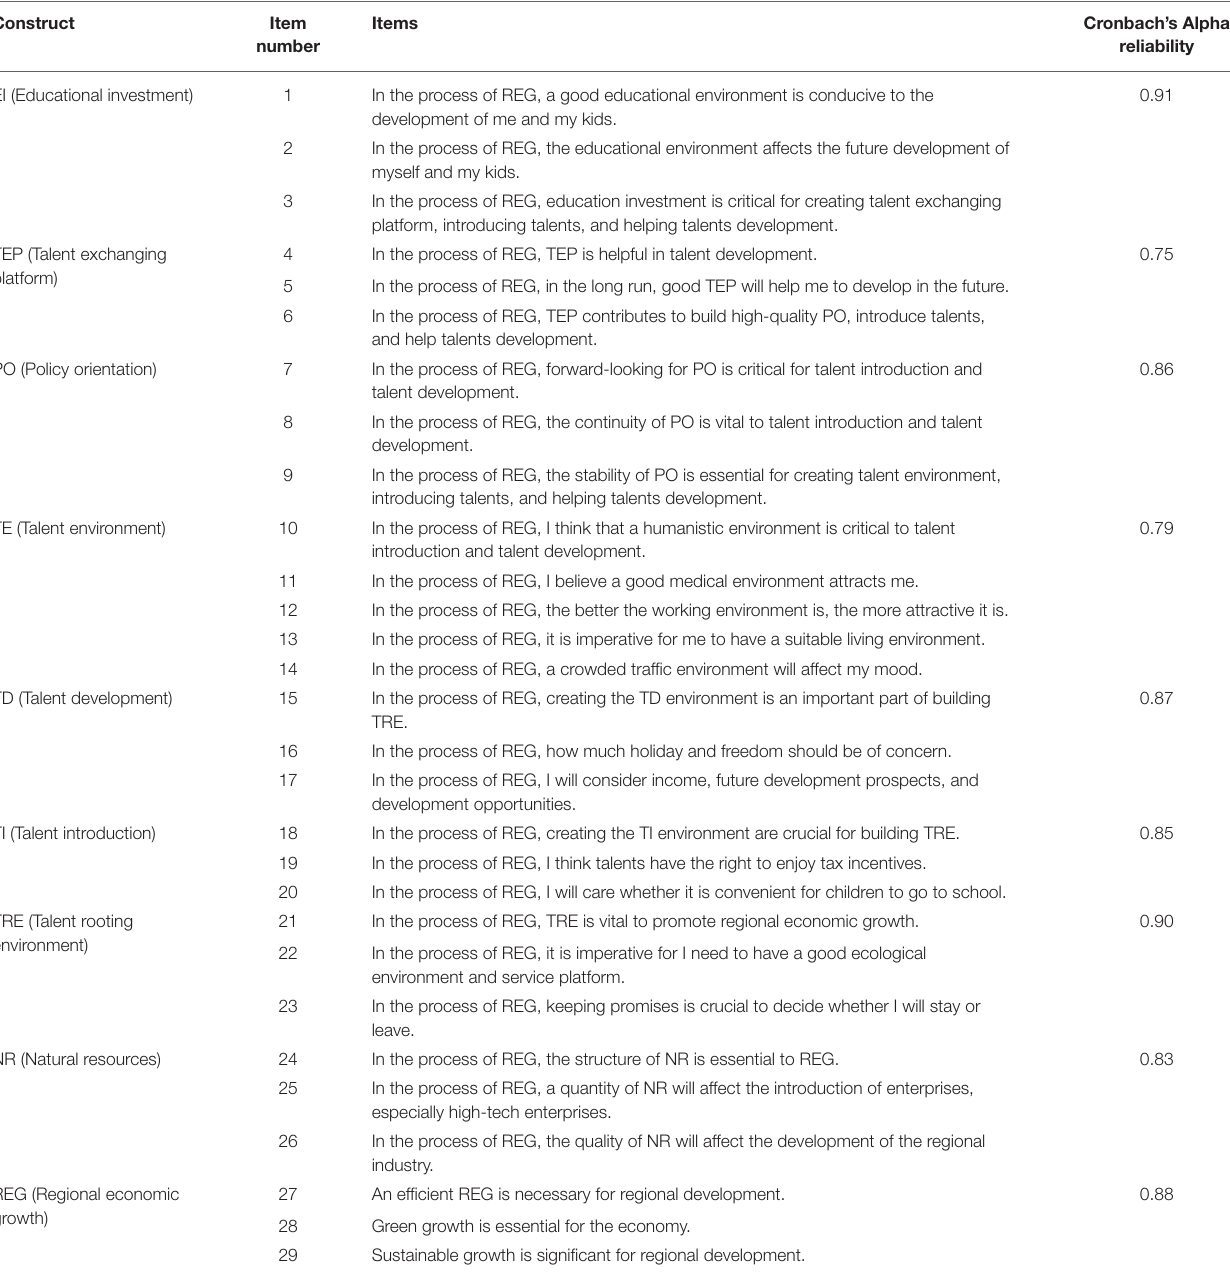
TABLE 1 | Items are applied to measuring various constructs in the model.